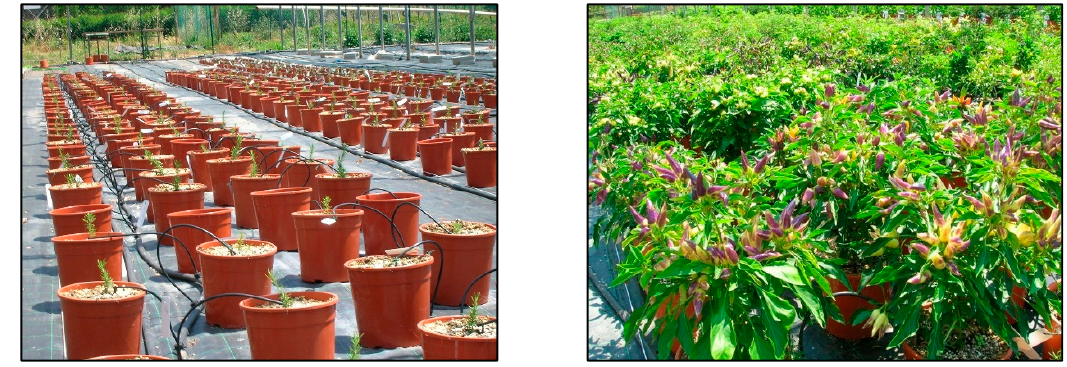
Figure 4. A view of ornamental pepper experimental field.